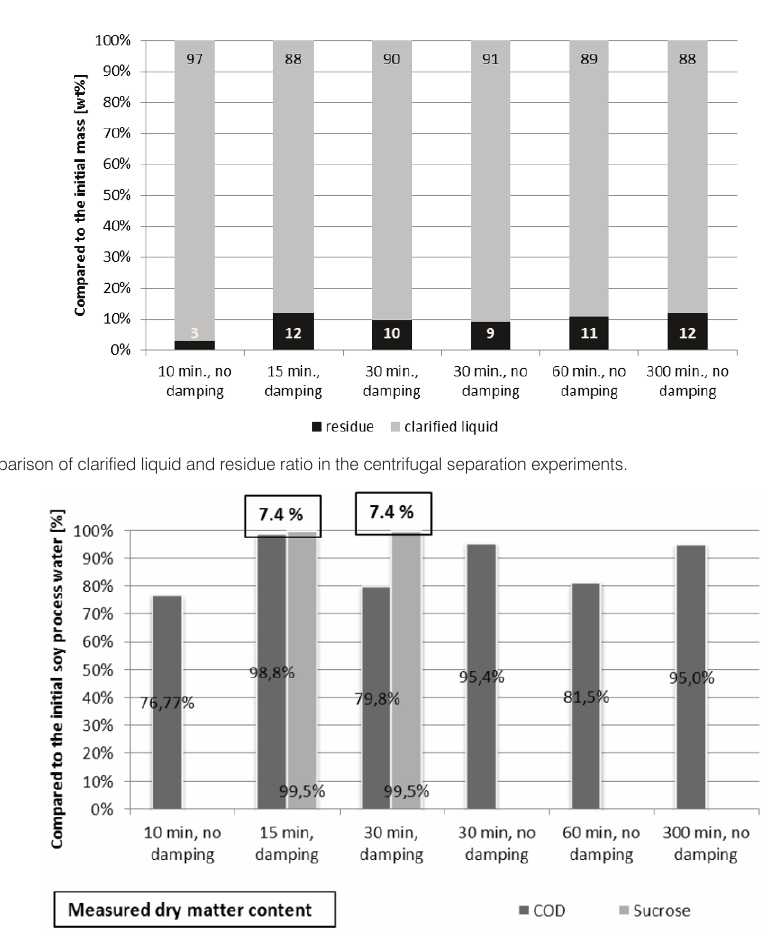
Figure 4. COD and sucrose reduction caused by centrifugal